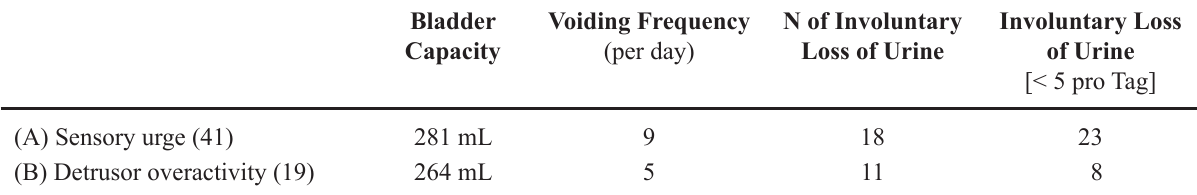
Table 3 – Comparison of group A (sensory urge) and group B (detrusor overactivity) The only significant difference in post-therapeutic improvement was found between the two groups for voiding